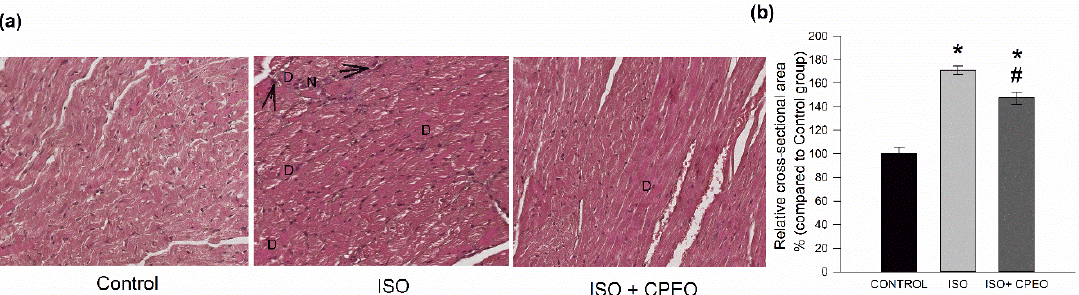
Figure 3. Effect of Cymbopogon proximus essential oil (CPEO) and/or isoproterenol (ISO) on myocardial architecture. Male albino rats were injected intraperitoneally daily with vehicle (Control), CPEO (800 µL/kg/d), ISO (5 mg/kg), or CPEO (800 µL/kg/d) plus ISO (5 mg/kg). Oil administration was started 4 d prior to ISO administration and continued concurrently thereafter for an additional 3 d. Histological examination and pathological changes in heart tissue. ( a ) Representative images of hematoxylin and eosin (H&E)-stained fields are shown for the left ventricles of rats of the control group and rats treated with ISO+CPEO or ISO alone (magnification, × 200), (necrosis (N); degeneration (D); pyknotic changes in the nuclei (arrows)) ( b ) Mean cross-sectional areas of cardiomyocytes from left ventricles of rats from the indicated experimental groups were calculated and are shown. The results are presented as the means of four independent experiments ± SEM. * p < 0.05 compared to control, # p < 0.05 compared to ISO-treated rats.